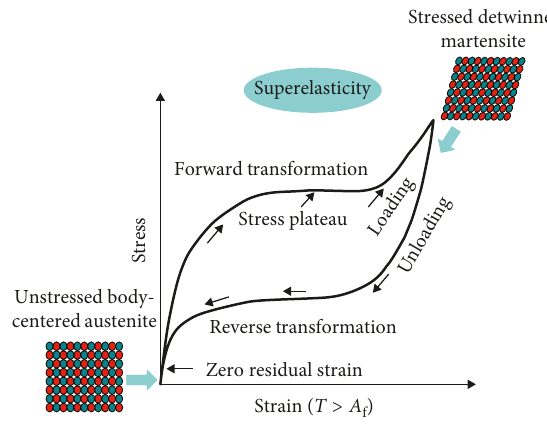
Figure 2: Schematic stress-strain curve of superelastic effect of